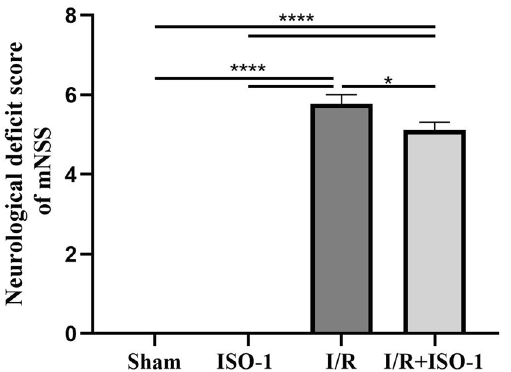
Figure 1. Behavioral assessment was performed by the mNSS test. Compared with the I/R group, scores were lower in the I/R + ISO-1 group. * P <